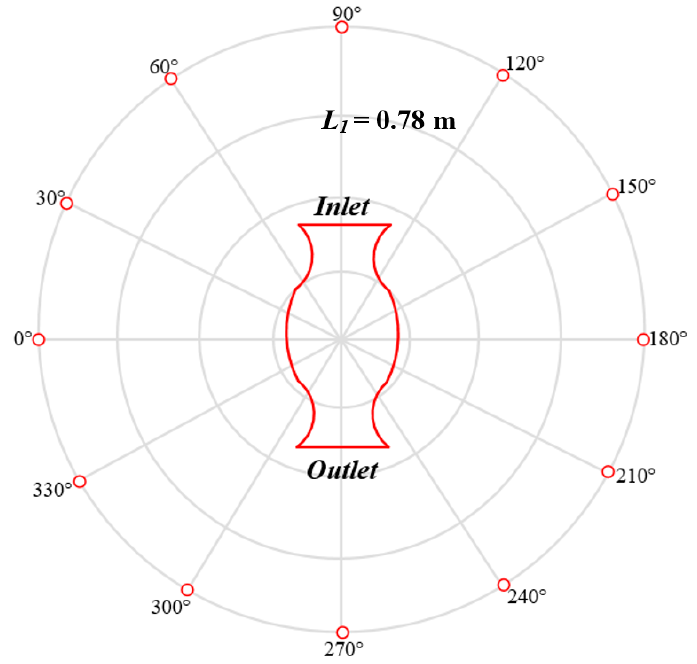
Figure 16. A noise test diagram.